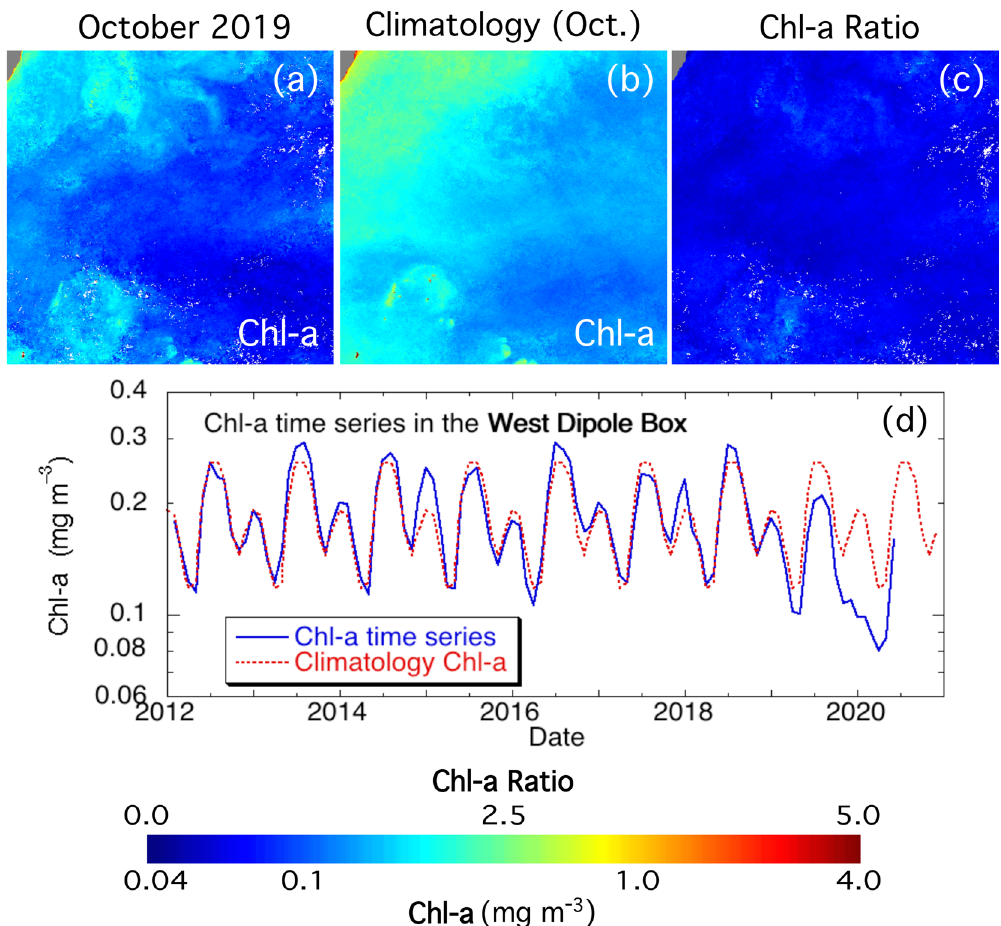
Figure 3. ( a ) Chl-a in October 2019, ( b ) Chl-a climatology in October, and ( c ) the ratio of Chl-a in October 2019 and climatology Chl-a in October in the west IOD zone. ( d ) Time series of the average Chl-a between 2012 and mid-2020 in the west IOD zone. The seasonal climatology average Chl-a is shown as a dashed line for